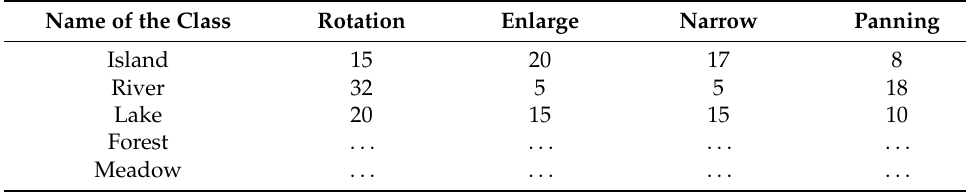
Table 3. The number of various geometric transformation in each class. Name of the Class